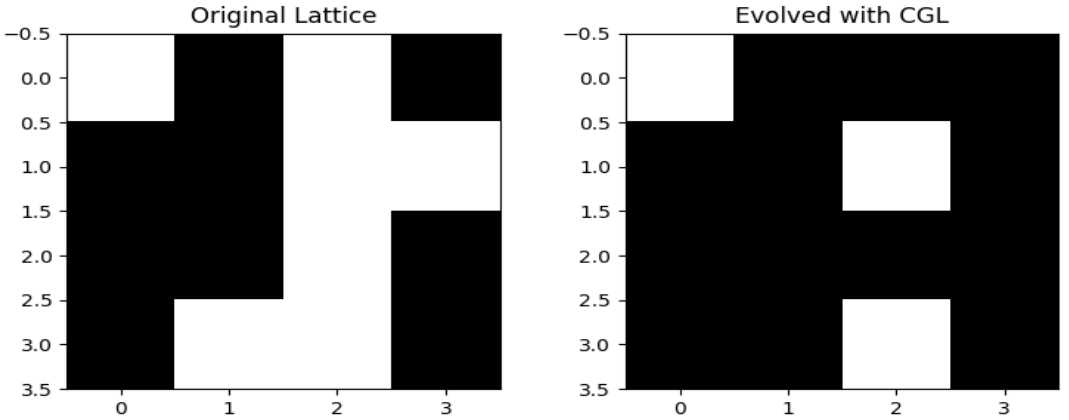
Figure 2. An example of a lattice evolved with CGL rule (Alive cells are white and black cells are dead). PBC and 𝑁 𝑀 are applied.